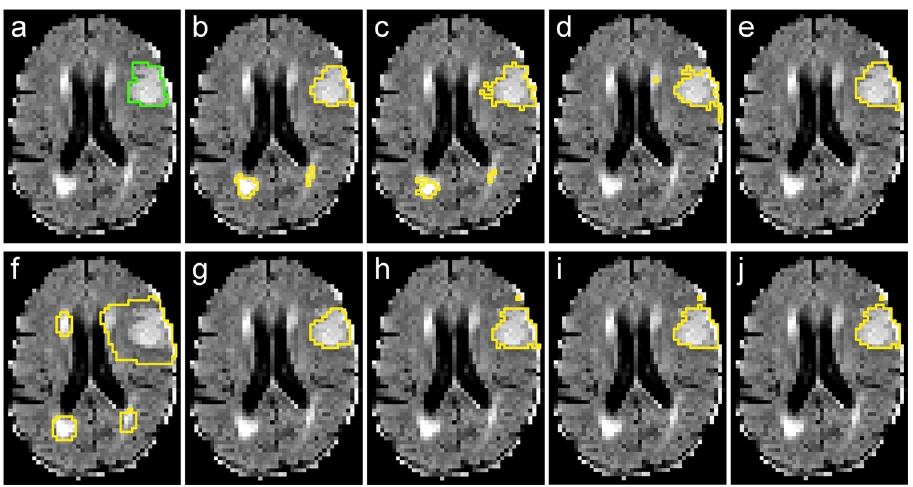
Fig 3. Results for case 04. Slice 30 with besteffort scenario trained on GTG. Note the presence of other white matter hyperintensities. (a) ground-truth (GTG). (b) 100NN. (c) 5NN. (d) AdaBoost. (e) ET. (f) GNB. (g) GLM. (h) GB. (i) RDF. (j)